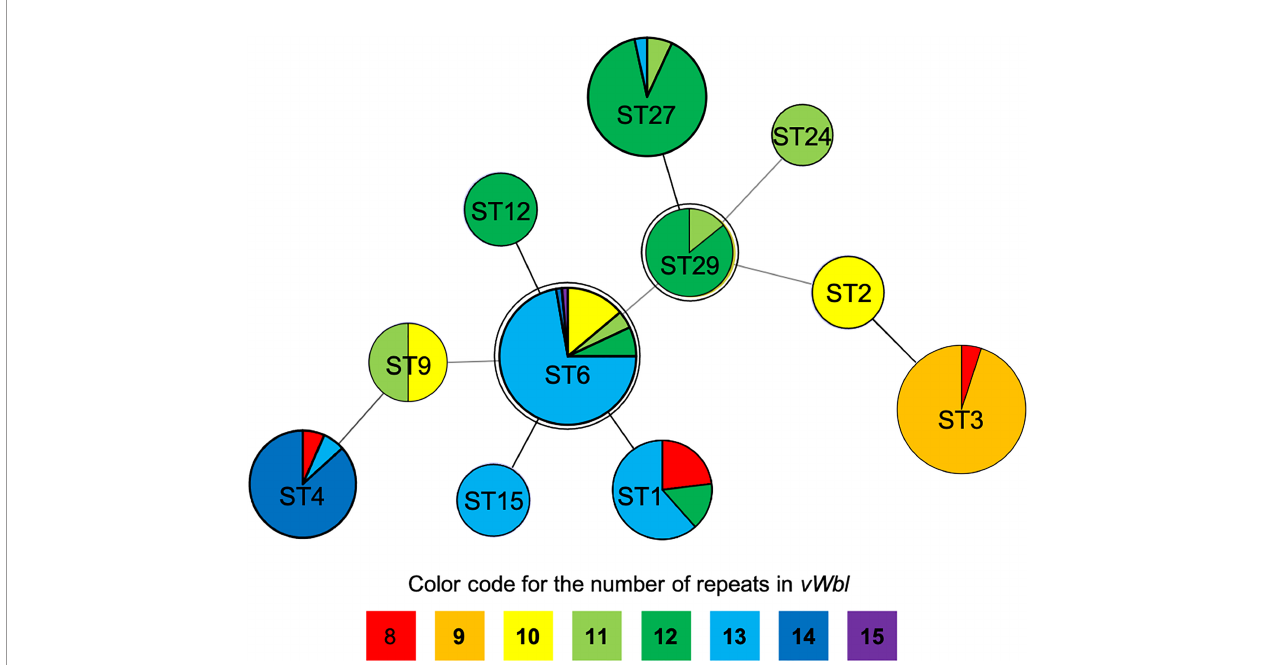
FIGURE 3 | Repeat copies distribution on eBURST diagram of STs. The double circles (ST6 and ST29) represent the founders in this diagram while different colors represent speci fi c repeats as displayed at the bottom of the phylogenetic